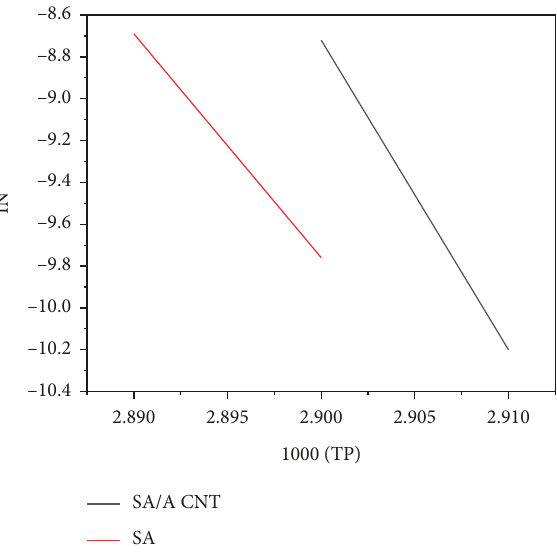
Figure 6: Kissinger curves of SA/A-CNT and